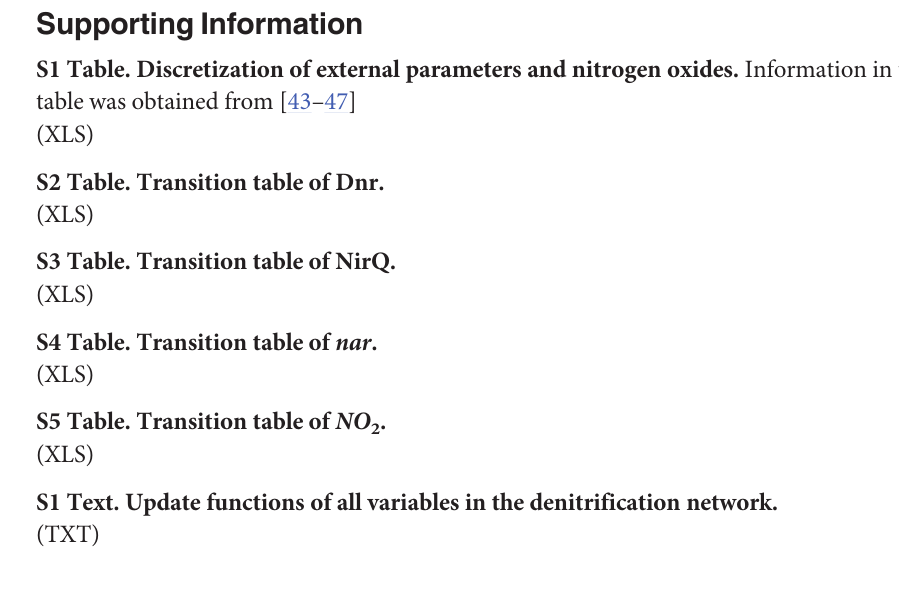
S1 Table. Discretization of external parameters and nitrogen oxides. Information in the table was obtained from [43 – 47] S2 Table. Transition table of Dnr. S3 Table. Transition table of NirQ. S4 Table. Transition table of nar . S5 Table. Transition table of NO 2